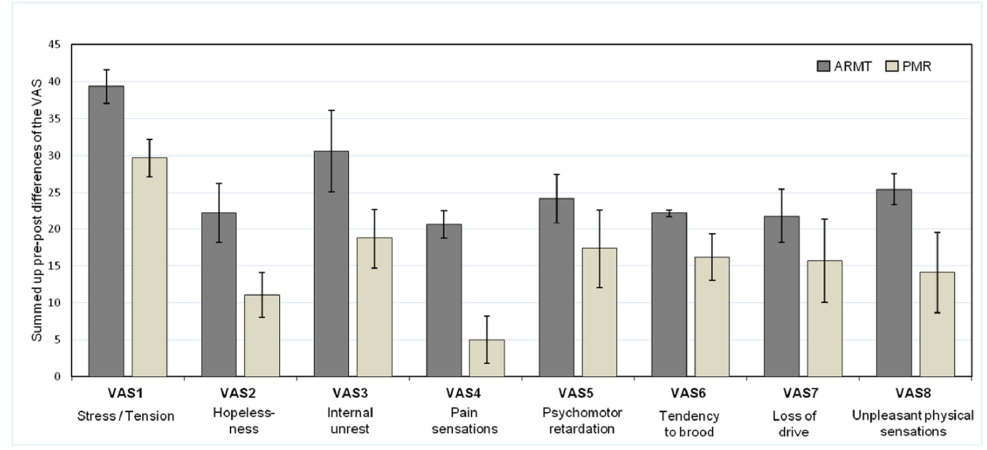
Figure 3. Summed up Bech–Rafaelsen Melancholia Scale (BRMS) scores in ARMT and PMR groups before ( T A ) and after ( T B ) completing the full series of treatments (mean ± SEM).